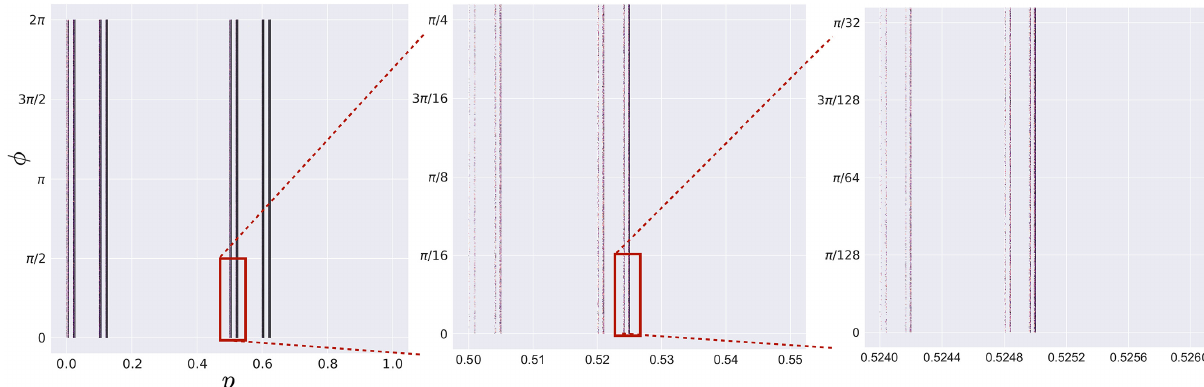
FIG. 3. Geometric quantum states visited along a single trajectory generated by the extended Baker’s map with parameters λ a = λ = 0.2, β = 4 π/ 10, and initial condition ( p φ ) = ( 0.328 65, 0.988 86 ) . We plot N = 10 7 time steps on the Bloch square ( p , φ) ∈ 0 , 0 b [0, 1] × [0, 2 π ]. Over time, due to the map’s chaotic nature, even a single trajectory covers a (strange) attractor, with self-similar (fractal) structure. More specifically, vertically, the attractor has a uniform structure. Horizontally, it has a self-similar, fractal structure, equivalent to a generalized Cantor set. This is demonstrated, going from the left panel to the right, via successively magnifying small subsets of states.